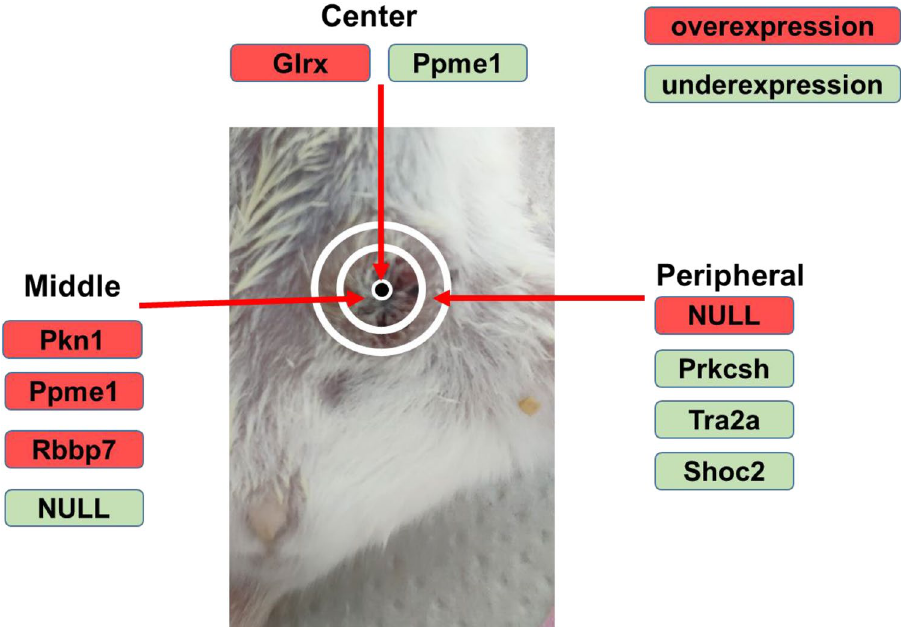
Figure 3. Molecular cartography of a 4T1 murine tumor, showing the potential tumor biomarker genes ( p value < 0.05) that are differentially expressed in a single one of the three spatial zones simultaneously compared ( p value < 0.05) to two others: center, middle, and periphery (Fig. 1). Overexpression direction (red) and underexpression direction (green) are indicated, NULL shows that no genes were funds under specific classification.